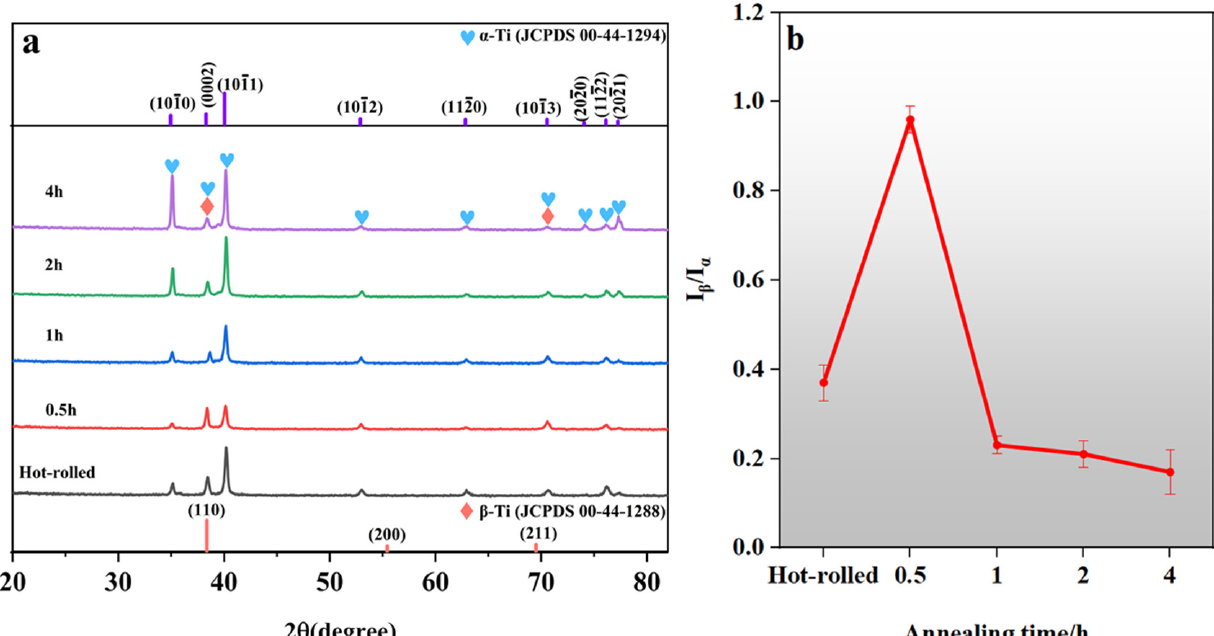
Figure 6. Microstructure evolution of TA10 annealed sheet.